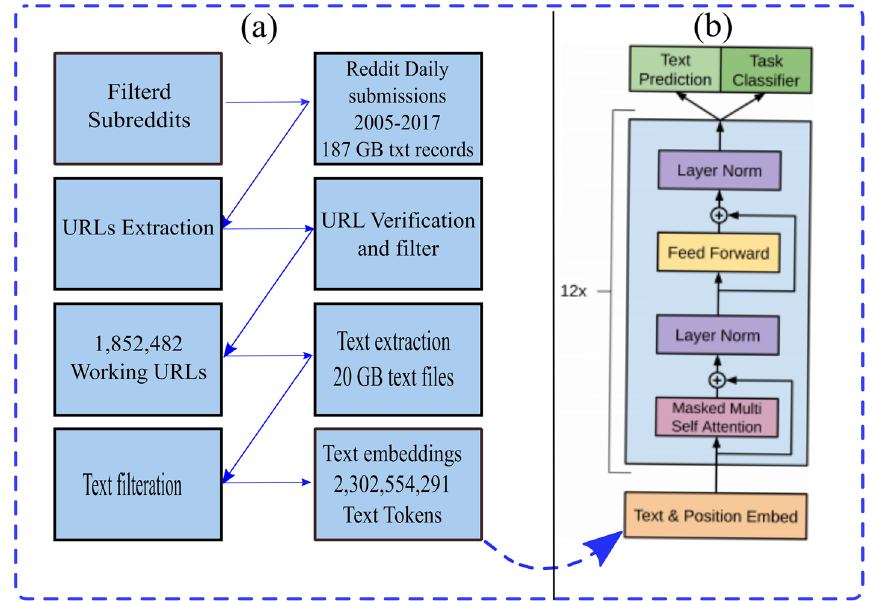
Fig. 1 Data preprocessing and network